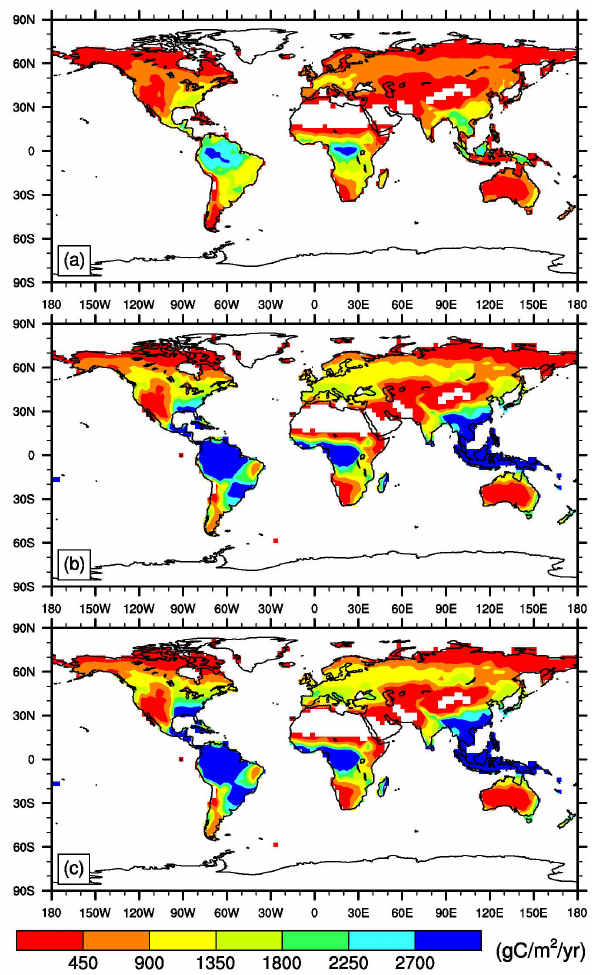
Fig. 3. Average GPP (g C m − 2 yr − 1 ) for the years 2000–2004, derived from (a) MODIS data (Zhao et al., 2005), (b) CROP, and (c) GRASS.